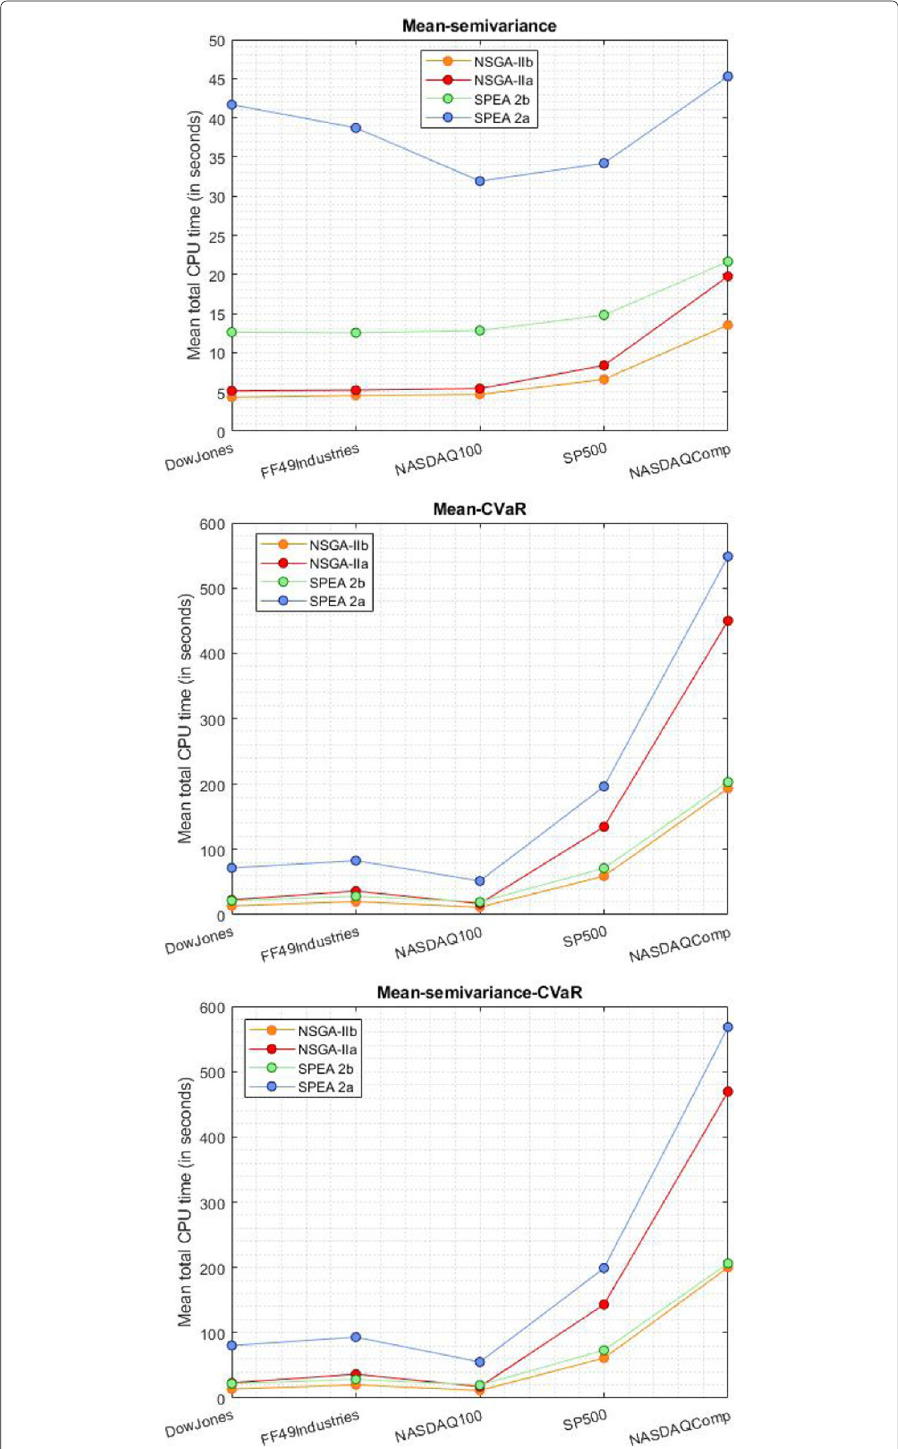
Fig. 3 Mean total CPU times (in seconds) for the Mean-semi-variance (charts at the top), Mean-CVaR (charts in the middle) and Mean-semi-variance-CVaR (charts below) portfolio optimization problems for 100,000 function evaluations of the algorithms NSGA-IIb, NSGA-IIa, SPEA 2b and SPEA 2a for the considered datasets over 20